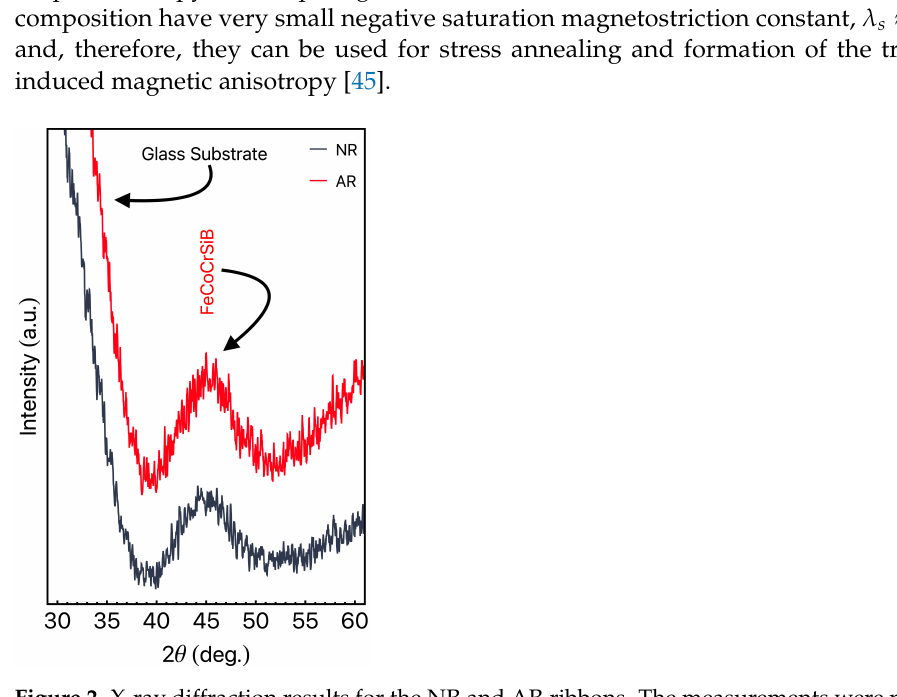
Figure 2. X-ray diffraction results for the NR and AR ribbons. The measurements were performed with the ribbons onto glass substrates without the use of silver